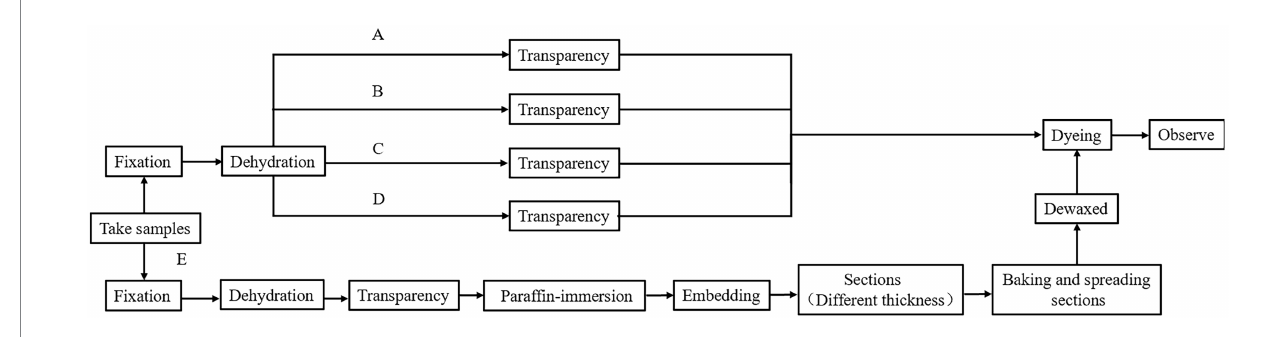
FIGURE 2 Flow chart of root system samples treatment of Chinese fir seedlings.